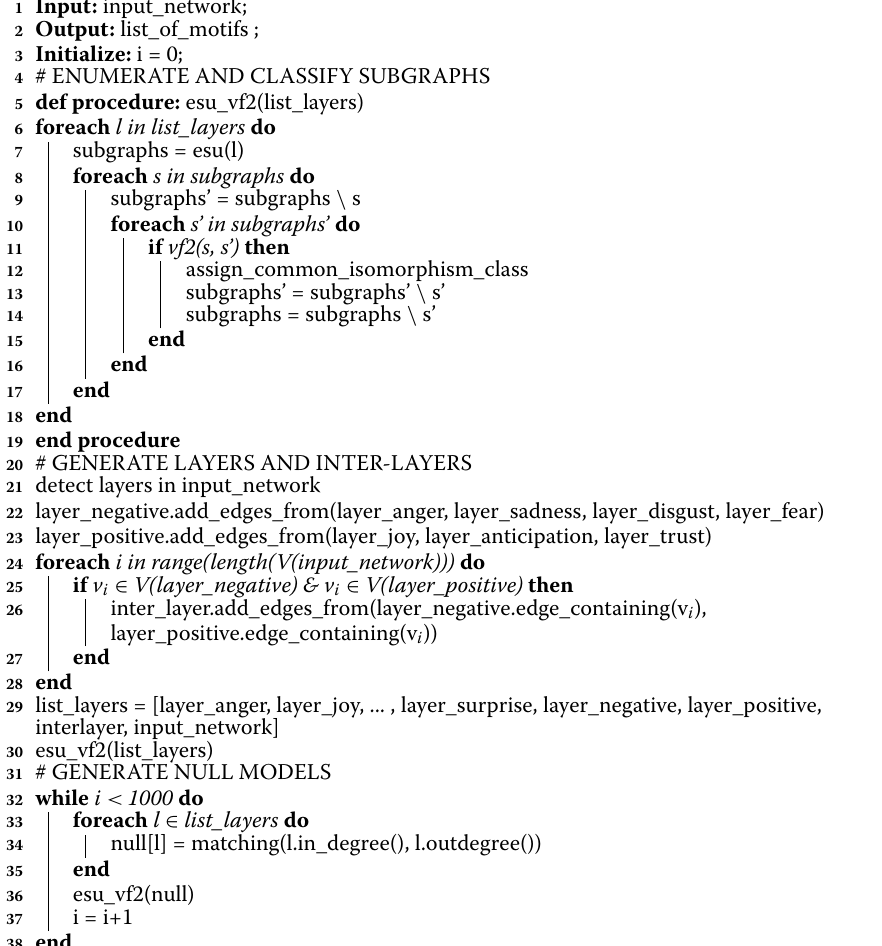
Algorithm 1: Motif